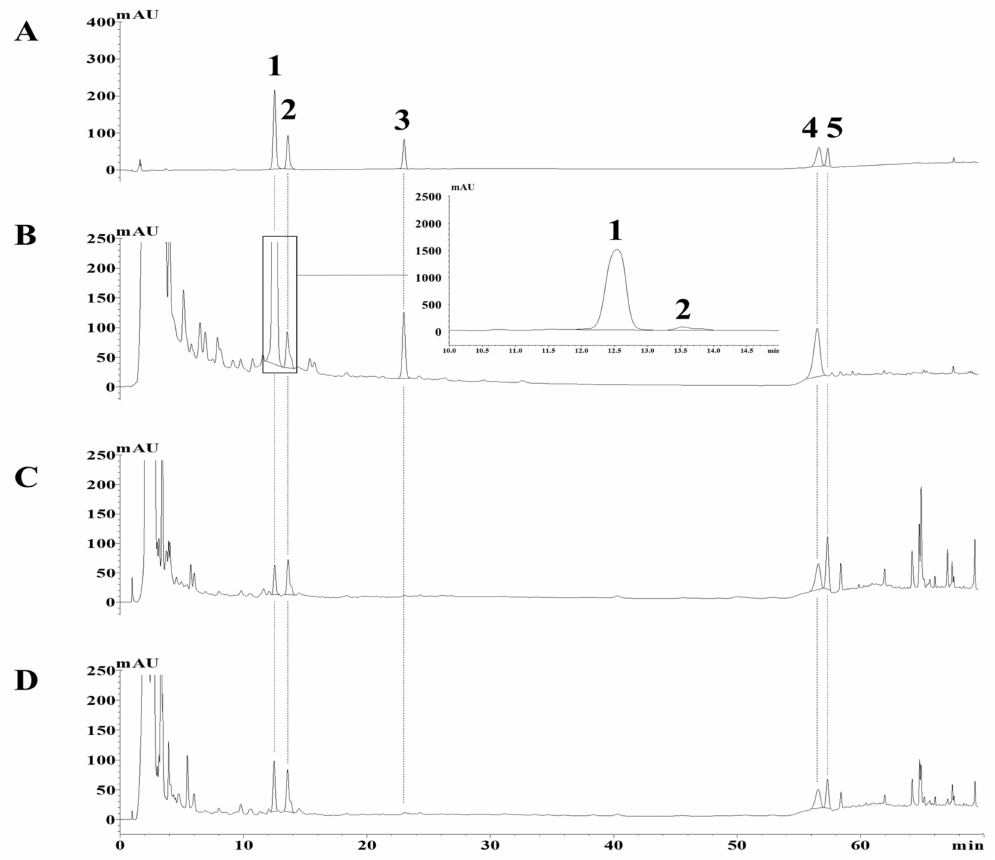
Figure 2. HPLC chromatograms of five standards ( A , 1 mg / mL); and the DN ( B , 40 mg / mL), DQ ( C , 40 mg / mL) and DS ( D , 40 mg / mL) samples. DN: Dioscorea nipponica; DQ: Dioscorea quinquelobata . DS: Dioscorea septemloba